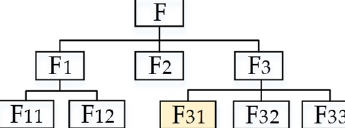
Figure 7. Technology Life Cycle Curve. Adapted with permission from Ref. [25]. 2021, Elsevier.